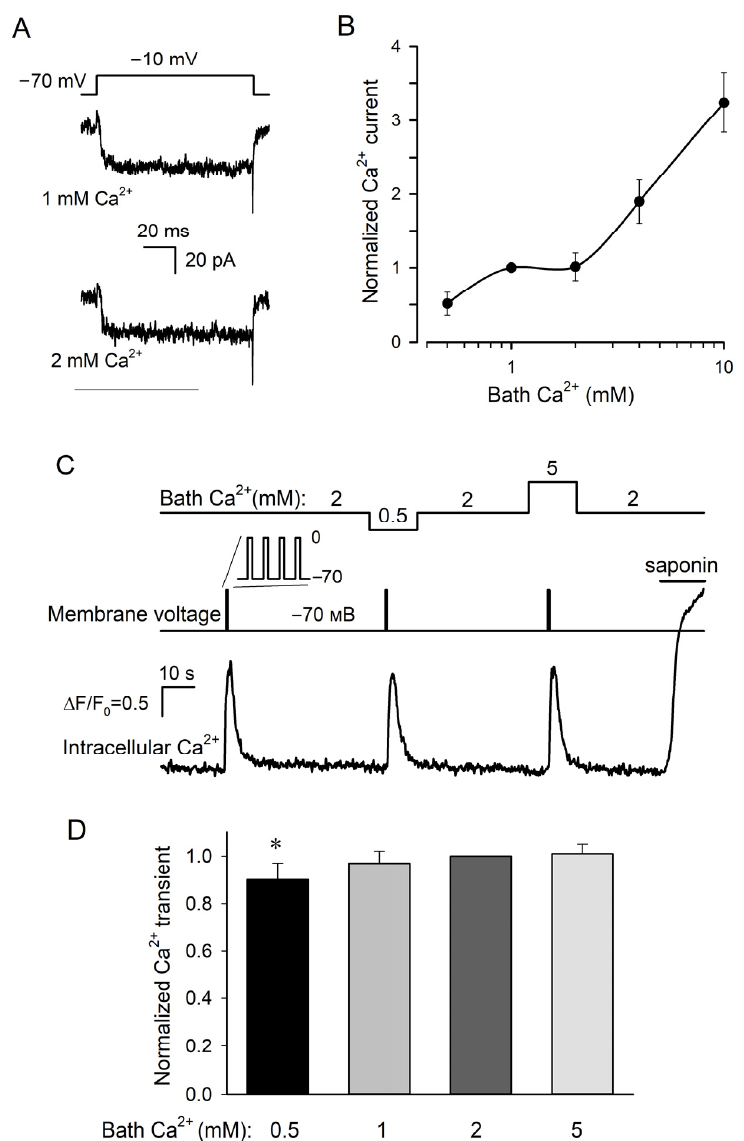
Figure 2. Dependencies of VG Ca 2+ currents and Ca 2+ transients on bath Ca 2+ . ( A ) Representative recording of Ca 2+ currents ( n = 49) at 1 and 2 mM Ca 2+ in the bath using the P/4 protocol and perforated patch approach. The cell was held at − 70 mV and polarized to − 10 mV by 100 ms voltage pulses. The recording conditions as in Figure 1A, except that the cell was pretreated with 10 µ M BAPTA-AM for 10 min and that 0.1 μ M forskolin was present in the bath. ( B ) The dependence of sustained VG Ca 2+ current at − 10 mV ( ● ) on bath Ca 2+ . This current was determined as a difference between integral currents recorded in control and in the presence of 50 μ M Cd 2+ . The solid line is a spline approximant. ( C ) Representative monitoring ( n = 17) of intracellular Ca 2+ (bottom trace) in a patch-clamped type III cell loaded with Fluo-8 at varied bath Ca 2+ (upper curve). The cell was held at − 70 mV and depolarized to 0 mV for 20 ms every 50 ms during 1 s (middle curve). The recording conditions as in Figure 1A, except that 0.1 μ M forskolin was present in the bath. Deviations of cytosolic Ca 2+ from a resting level were quantified by the ratio Δ F/F 0 , where Δ F = F − F 0 , F is the instant Fluo-8 fluorescence, F 0 is the averaged fluorescence at the very beginning of the recording. ( D ) Averaged Ca 2+ transient elicited in type III cells by depolarization as in ( C ) at bath Ca 2+ varied from 0.5 to 5 mM. In each particular experiment, Ca 2+ transients at varied bath Ca 2+ were normalized to a Ca 2+ response at 2 mM Ca 2+ . The data are presented as the mean ± S.D. ( n = 14–17). Unlike the Ca 2+ burst at bath Ca 2+ of 0.5 mM, the depolarization elicited Ca 2+ transients at 1, 2, and 5 mM were statistically indistinguishable ( p > 0.01, Student’s t -test). The asterisk means statistically representative difference ( p =